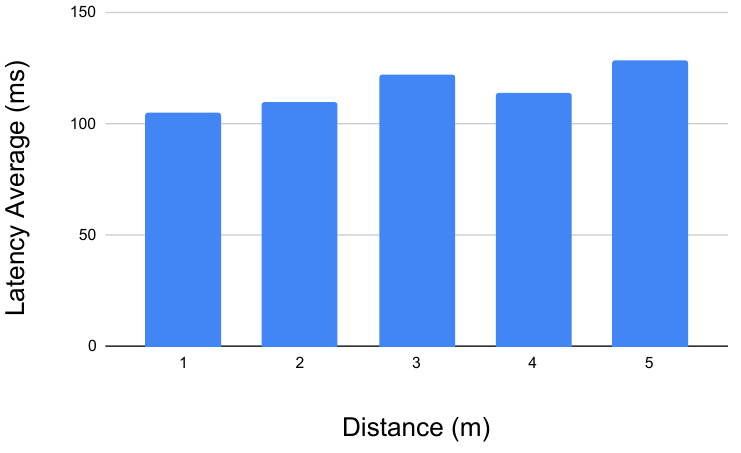
Figure 34. Latency results obtained when requesting the onboard Android Device camera picture (i.e., 640 × 480 pixels JPEG